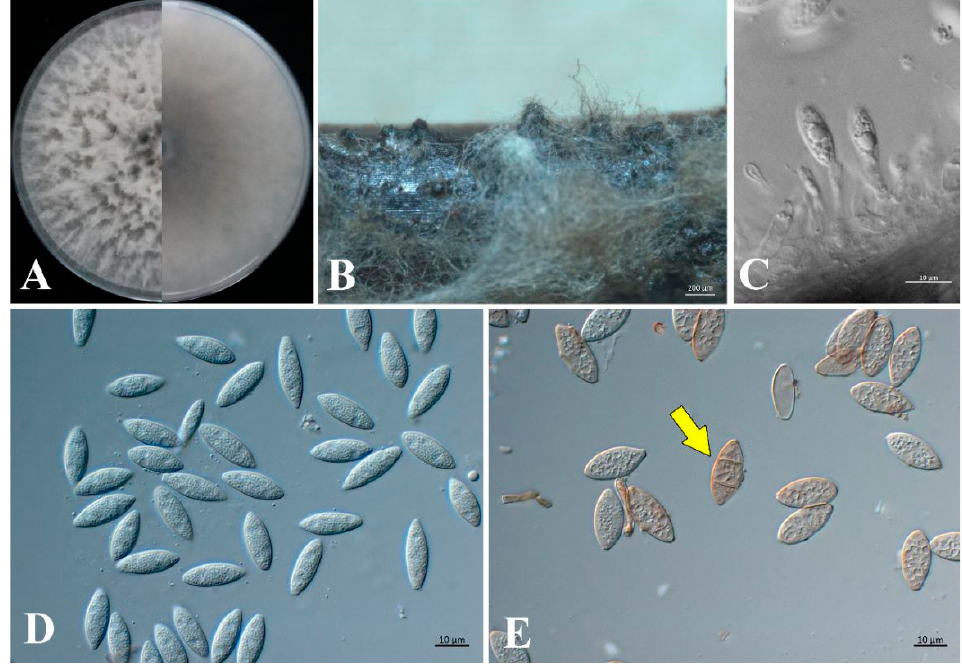
Figure 6. Morphology of Neofusicoccum parvum (G15). ( A ) Five-day-old front and back view culture on PDA. ( B ) Conidioma formed on pine needle culture. ( C ) Conidiogenous cells and developing conidia. ( D ) Hyaline conidia. ( E ) Brown, septate conidia (indicated by arrow). Scale bars: ( B ) = 200 µm; ( C – E ) = 10 µm.